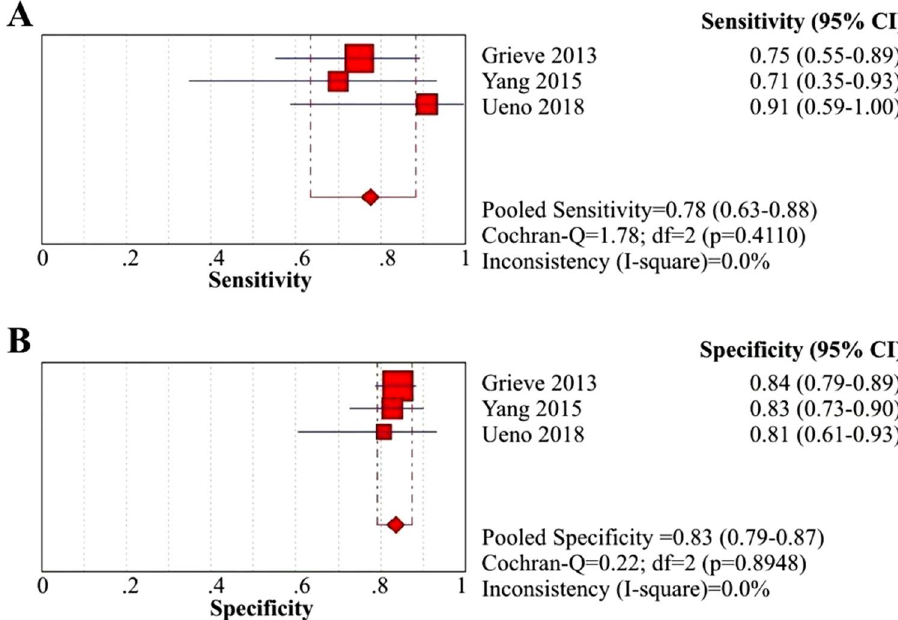
Figure 7. Coupled forest plots of the sensitivity and specificity of APRi for post-KPE cirrhosis. ( A ) Sensitivity of APRi for cirrhosis; ( B ) Specificity of APRi for cirrhosis.